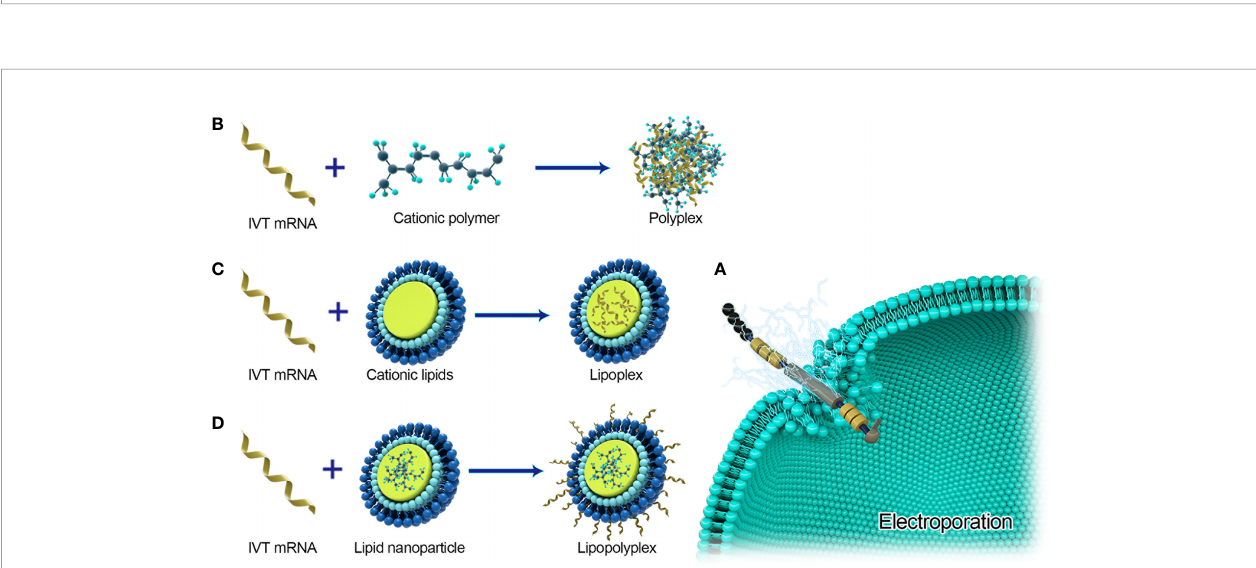
FIGURE 4 | Major delivery systems for mRNA vaccines. (A) Electroporation for naked mRNA delivery. (B) Polyplexes are formed by spontaneously interacting with negatively charged IVT-mRNA and cationic lipids. (C) Lipoplexs formed by loading mRNA into cationic lipids. (D) Lipopolyplexs are formed by a polymer ‘ core ’ and a lipid ‘ shell ’ with IVT-mRNA absorbed on the surface of the